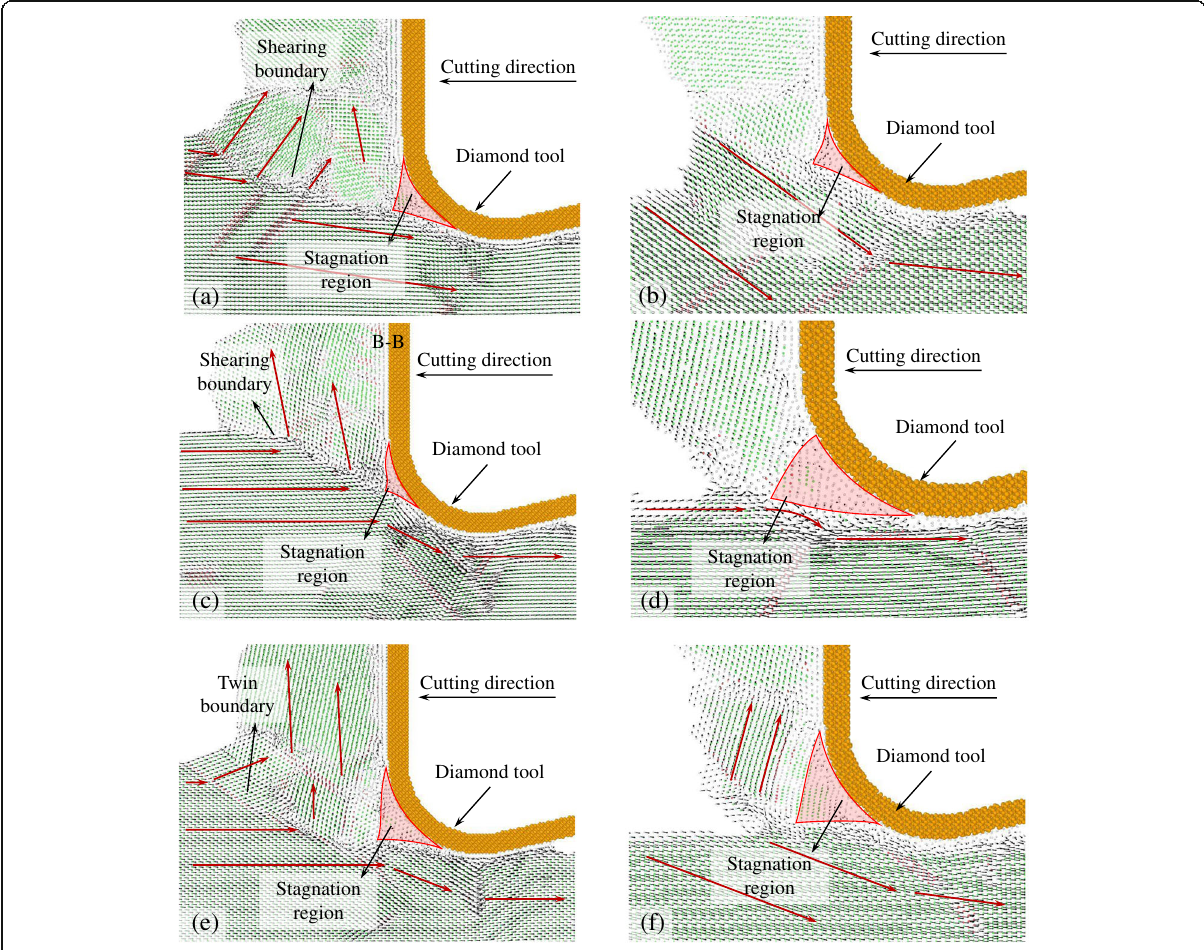
Fig. 5 Displacement vectors at cutting direction of {100} < 001>, and slice plane of ( a ) B-B, ( b ) C-C; cutting direction of {100} < 011>, and slice plane of ( c ) B-B, ( d ) C-C; cutting direction of {110} < 001>, and slice plane of ( e ) B-B, ( f )